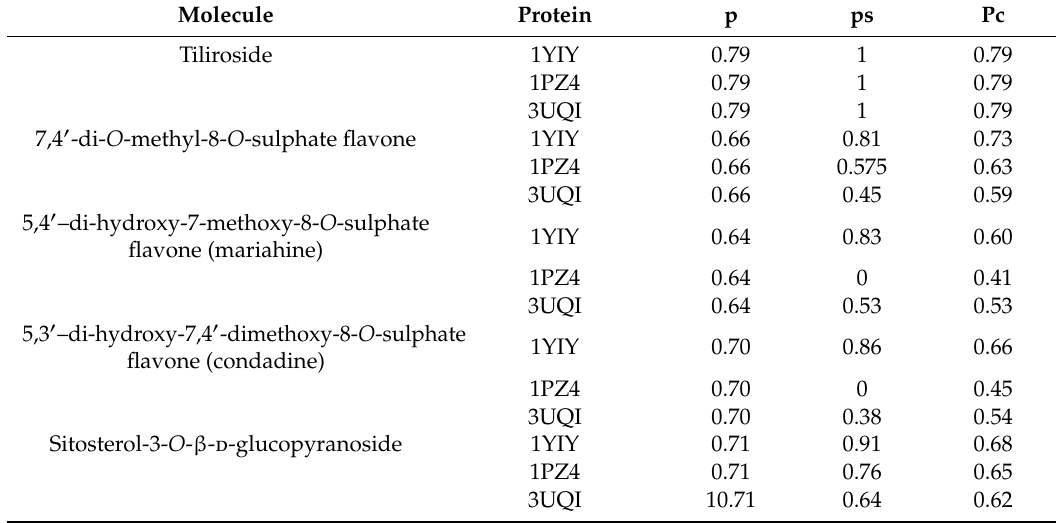
Table 4. Summary of the best-ranked structures obtained using an approach combining ligand-based and structure-based virtual screening (VS); p = active probability value in ligand-based VS; ps = active probability value in structure-based VS; Pc = combined probability